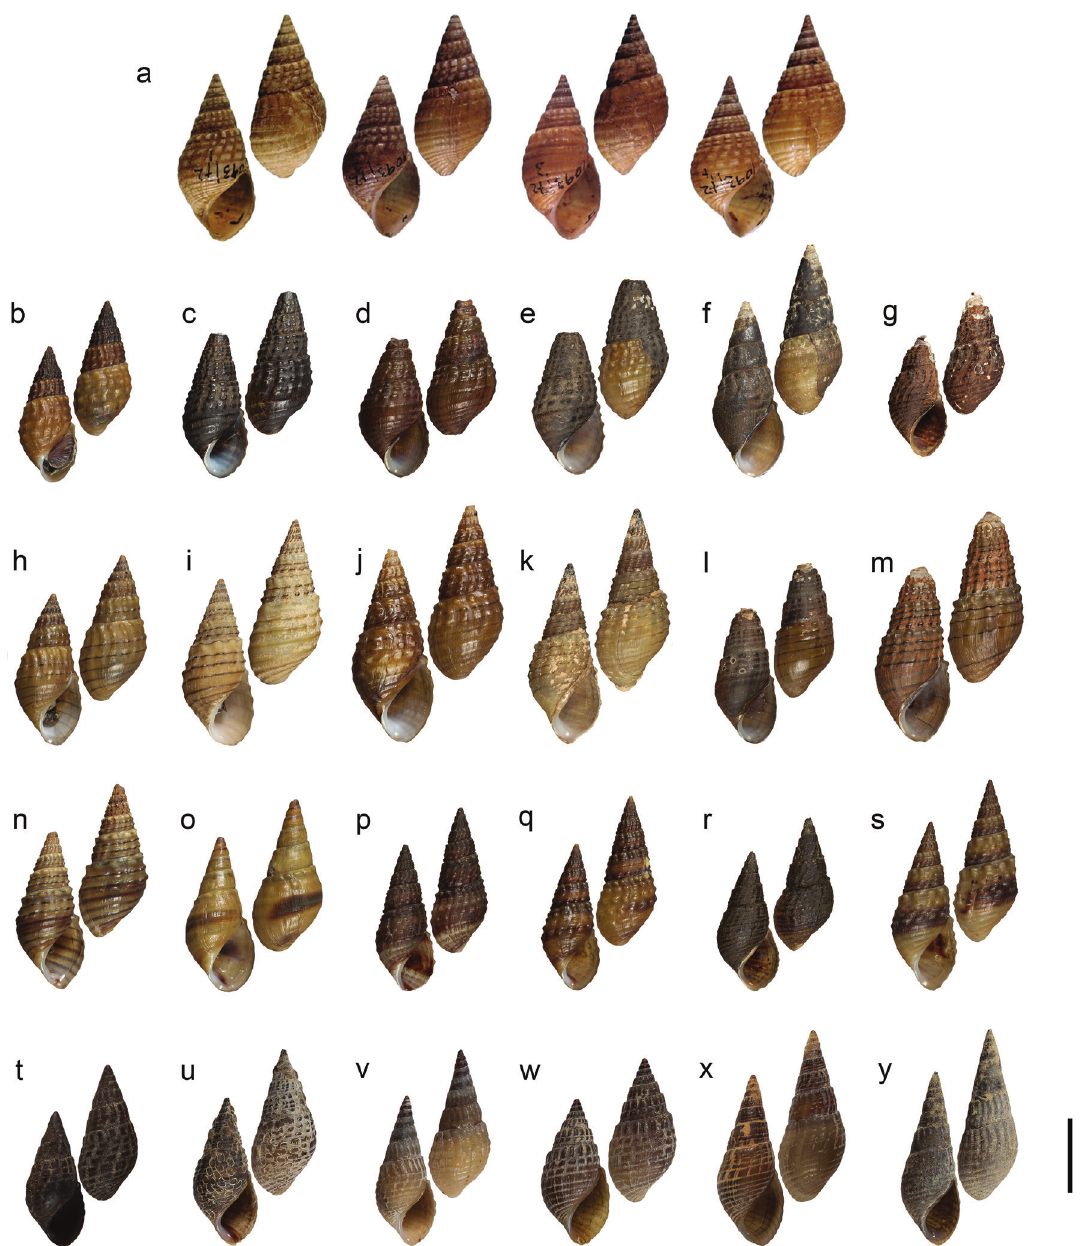
Figure 2. Shells of Tarebia granifera (Lamarck, 1816) from Timor and Thailand. a . Syntypes (MHNG 1093/72/1-4) from Timor. b–g . Morph A, i.e. specimens from Thailand corresponding to T. granifera (SUT 0514044, SUT 0516123, SUT 0515088, SUT 0515068, SUT 0515059, SUT 0516144). h–m . Morph B, i.e. specimens from Thailand corresponding to named T. lineata